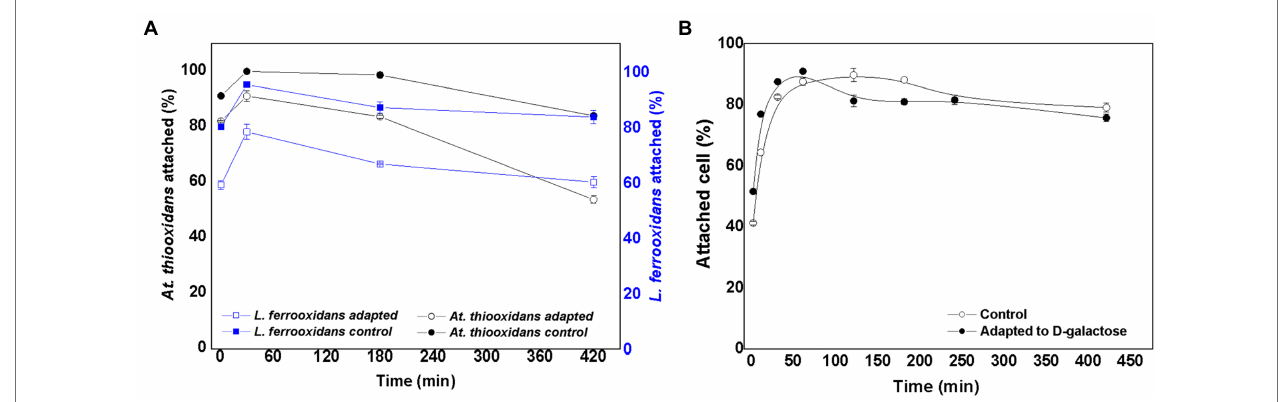
FIGURE 2 | Attachment percentage to the mineral over time for the consortium in proportion 50:50 of At. thiooxidans DSM 14887 T and L. ferrooxidans DSM 2705 T , respectively. (A) Data obtained by qPCR. (B) Data obtained by counting total planktonic cells using a Neubauer chamber. The data correspond to the mean values of triplicates ± SD ( n = 6).